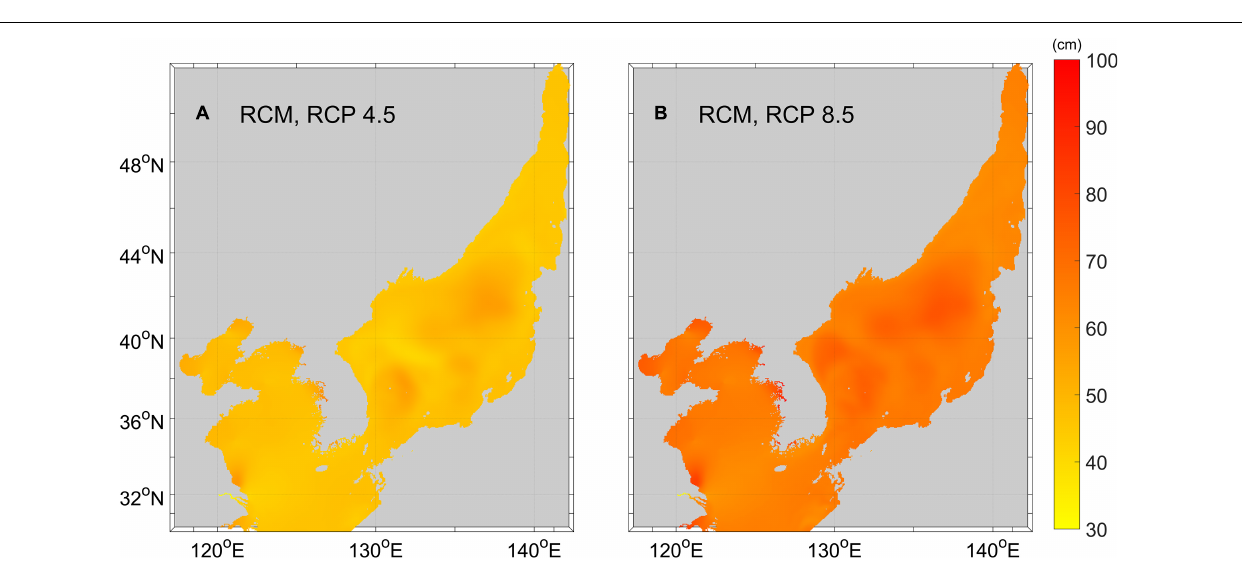
Frontiers in Marine Science |